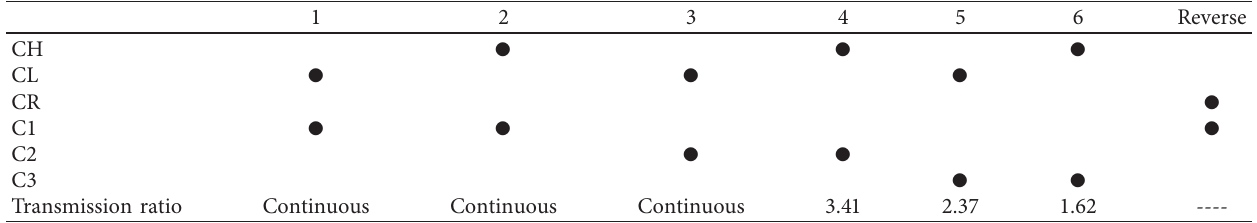
Figure 1: Schematic diagram of the studied vehicle power train. (a) Arrangement diagram. (b) Transmission diagram of gearbox. Table 1: The list of each gear operation method.